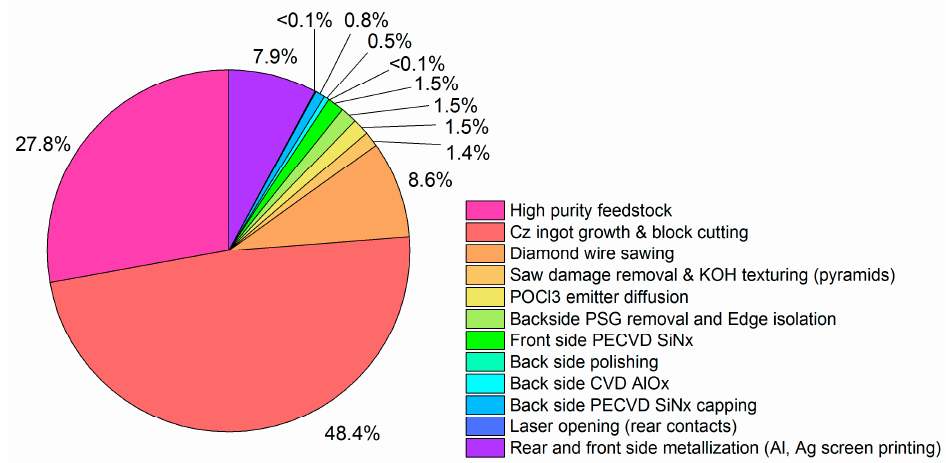
Figure 2. Sum of the normalized costs for the PERC process steps for the reference device (standard texturized Czochralski PERC).